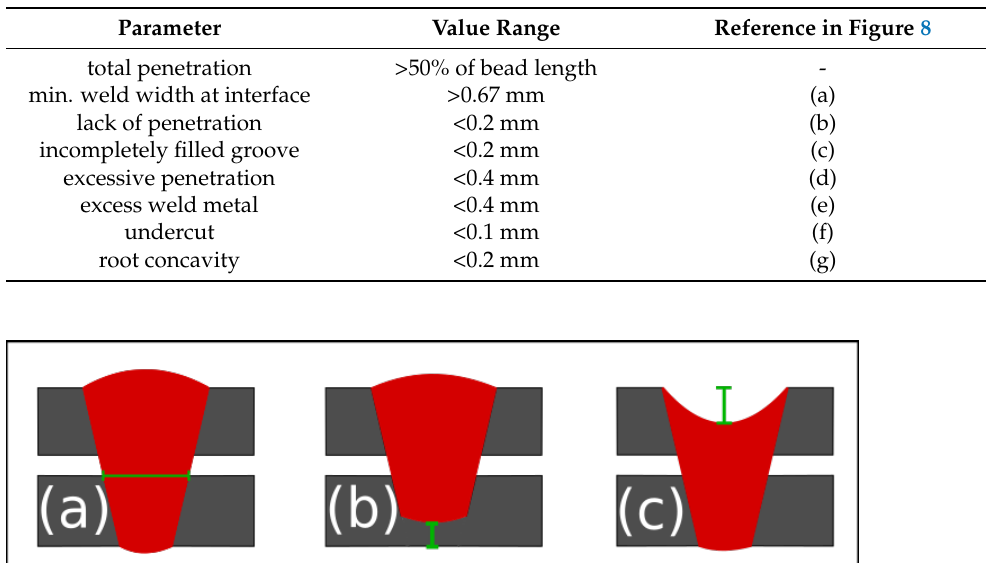
Table 2. Weld quality requirements as defined by the industry partner.